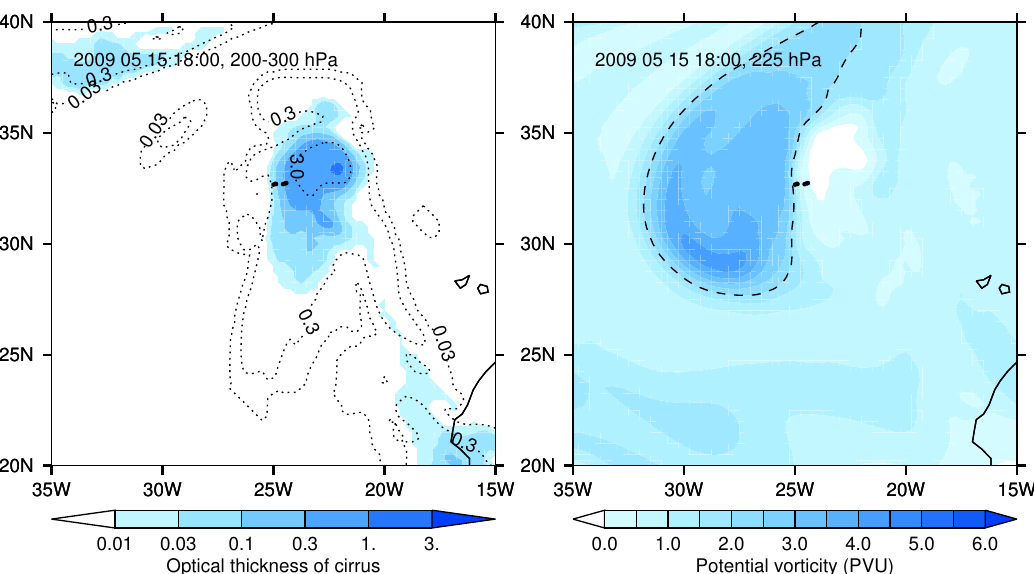
Figure 8. ( Left ): Optical thickness of cirrus clouds for the situation of Figure 5. The black dotted lines represent the optical thickness integrated over the 200 to 300hPa layer, while the coloured contours present the contribution of the layer around 225 hPa only. ( Right ): Field of potential vorticity (in PVU). The dashed line marks the 2 PVU surface, the dynamical tropopause or lower boundary of the tropospheric transition layer.